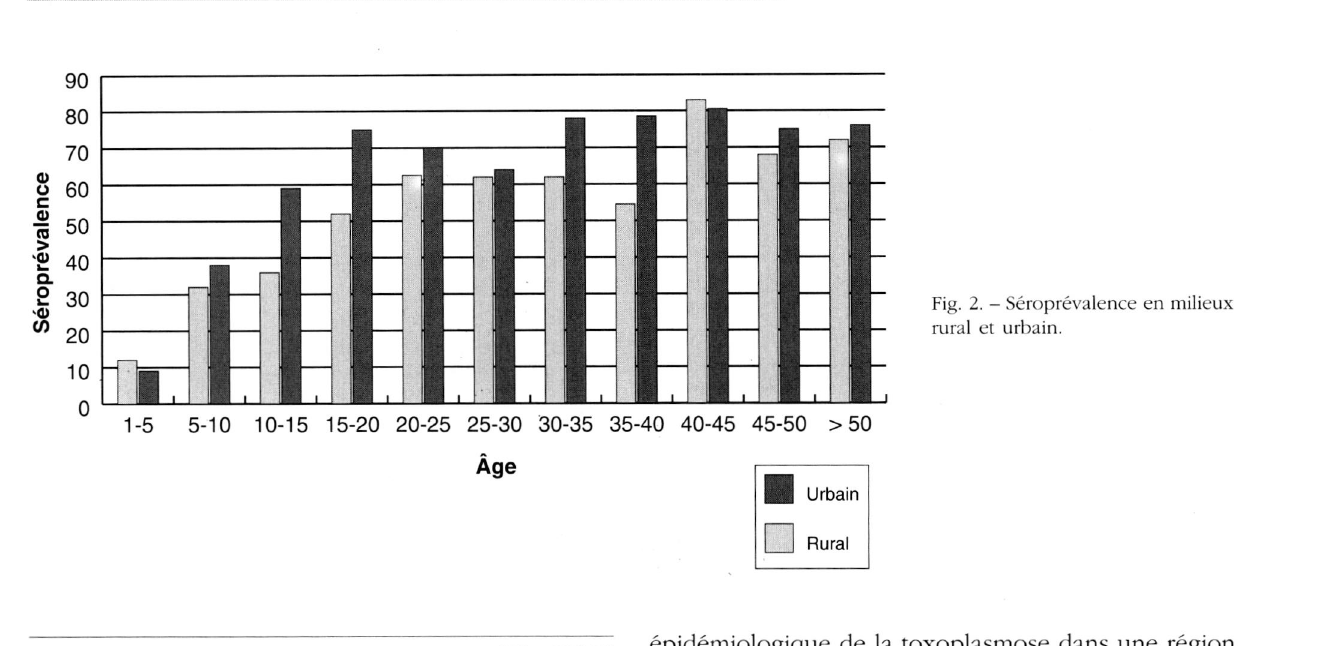
Fig. 2. - Séroprévalence en milieux rural et